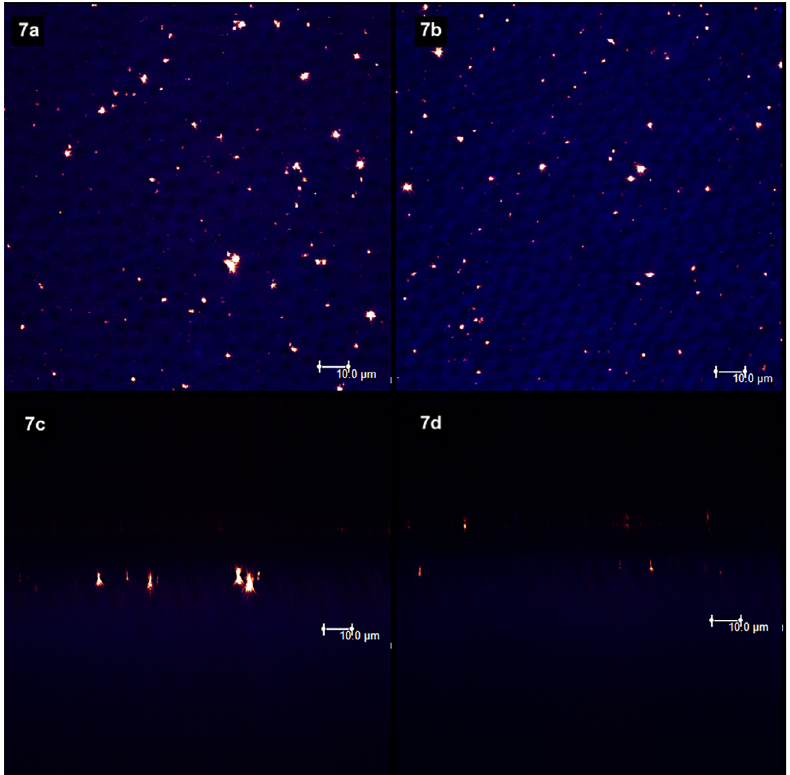
Figure 7- Few solid deposits are seen on the dentin surface (7a) and the aperture of tubules (7c) after the application of the 30 wt.% S-PRG-based toothpaste. After the erosive challenge, the number and size of particles on the surface (7b) and at the aperture (7d)